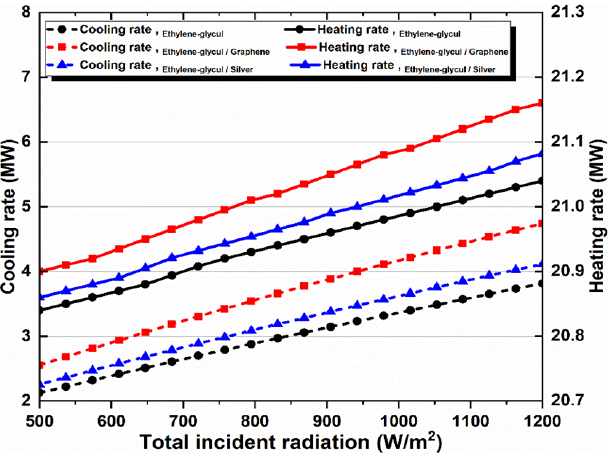
Figure 8. Effect of solar irradiation on heating and cooling loads.